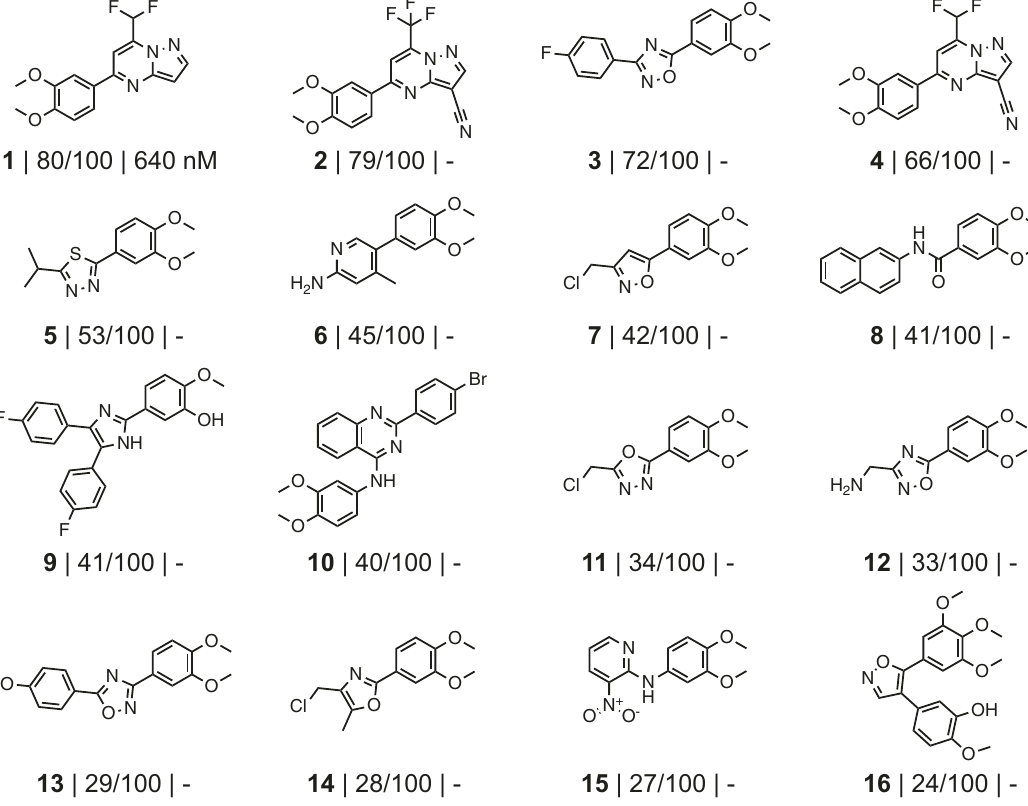
binding constant K d . The absence of a value ( − ) indicates no observed binding of the compound to the